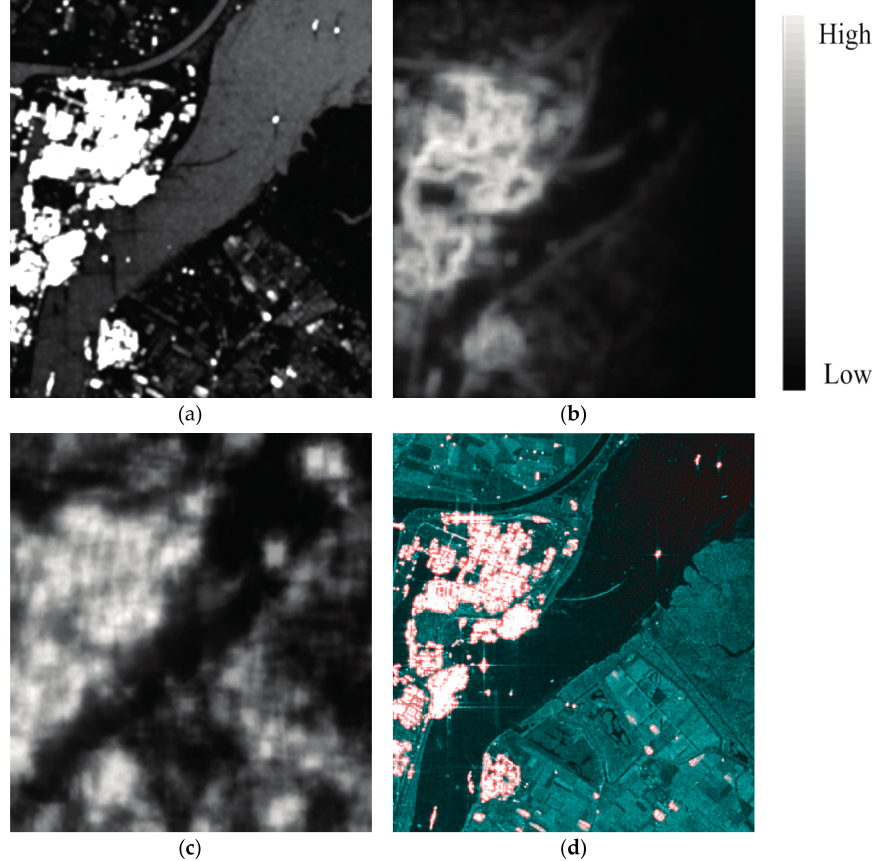
Figure 7. SaliencymapgenerationresultsofdifferentmethodsusingtheSentinel-1dataset. ( a ) The proposed method; ( b ) The IVSaliency method; ( c ) The PRSaliency method; ( d ) Original SAR image overlaid with the saliency map of ( a ), where the red regions are